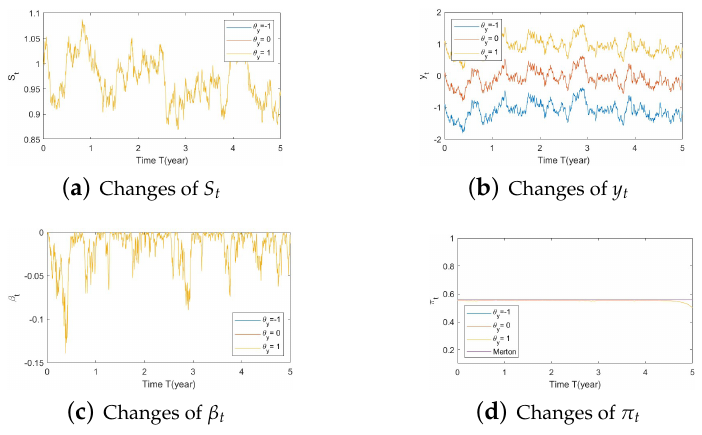
Figure A8. Illustrate the impact on ( a ) stock prices, ( b ) driver of elasticity, ( c ) elasticity of volatility, and ( d ) optimal stock allocations when varying θ y ( e . g ., θ y = − 1,0,1 ) .